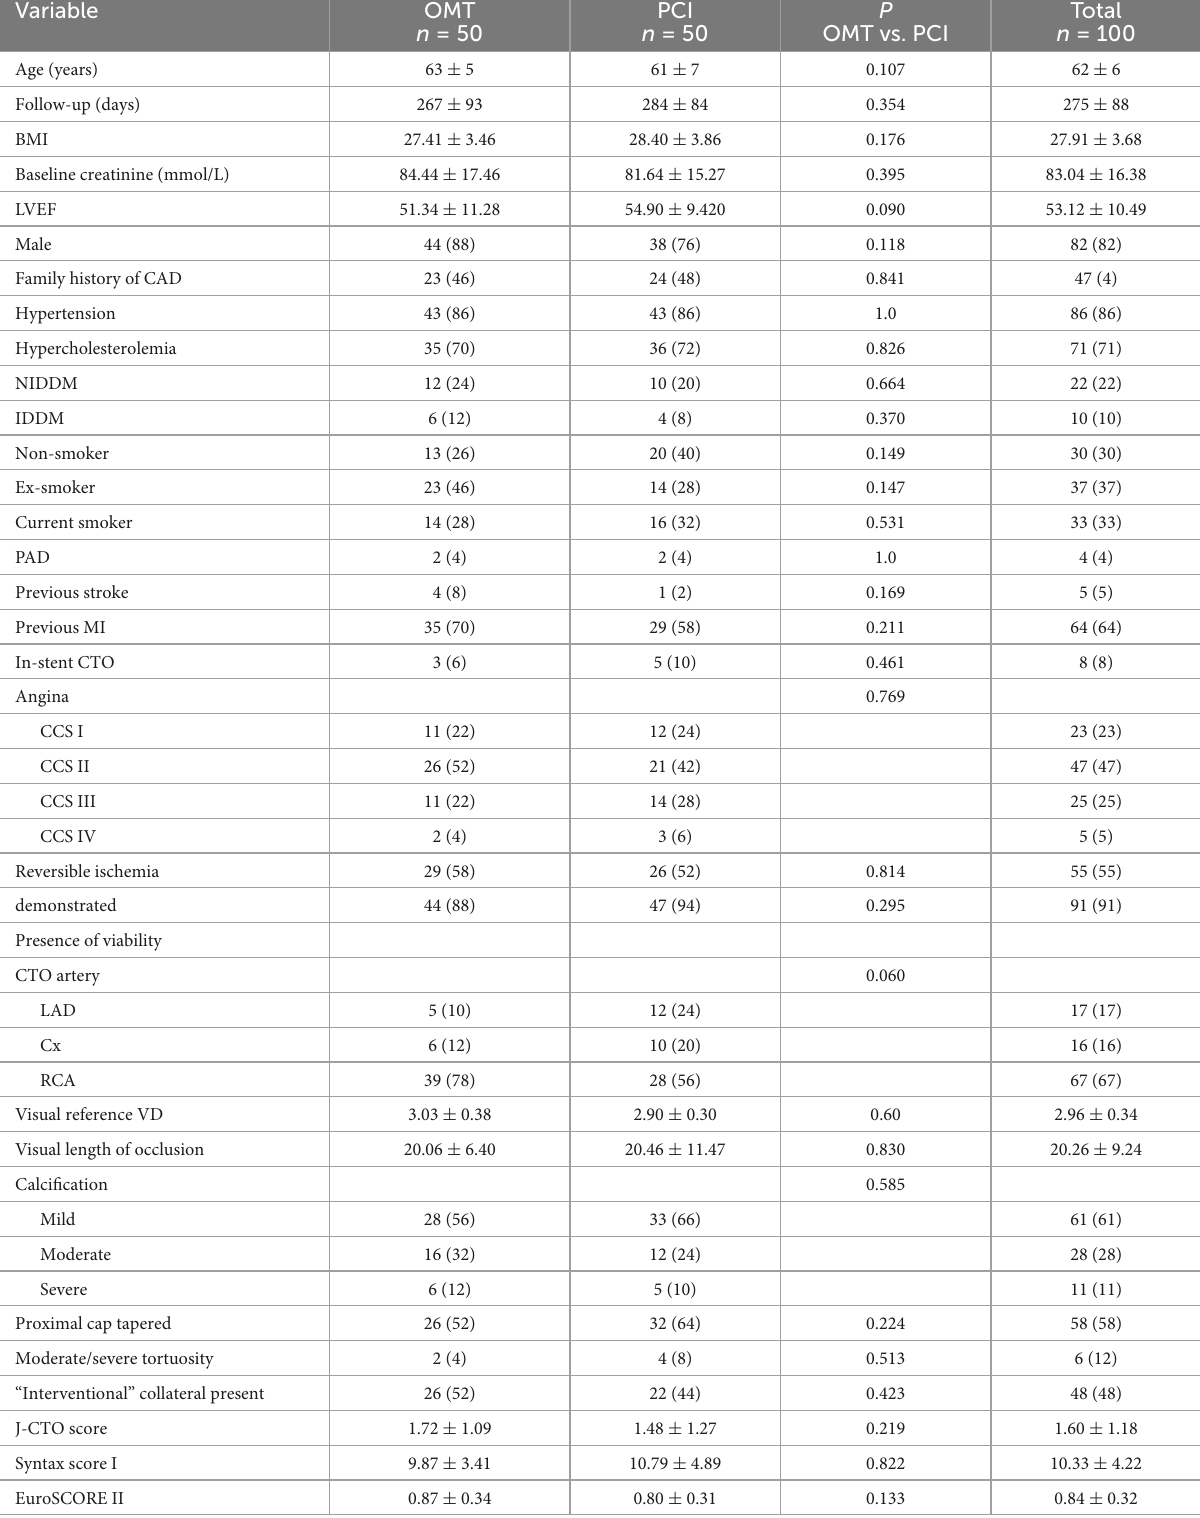
TABLE 1 Baseline patient and lesion